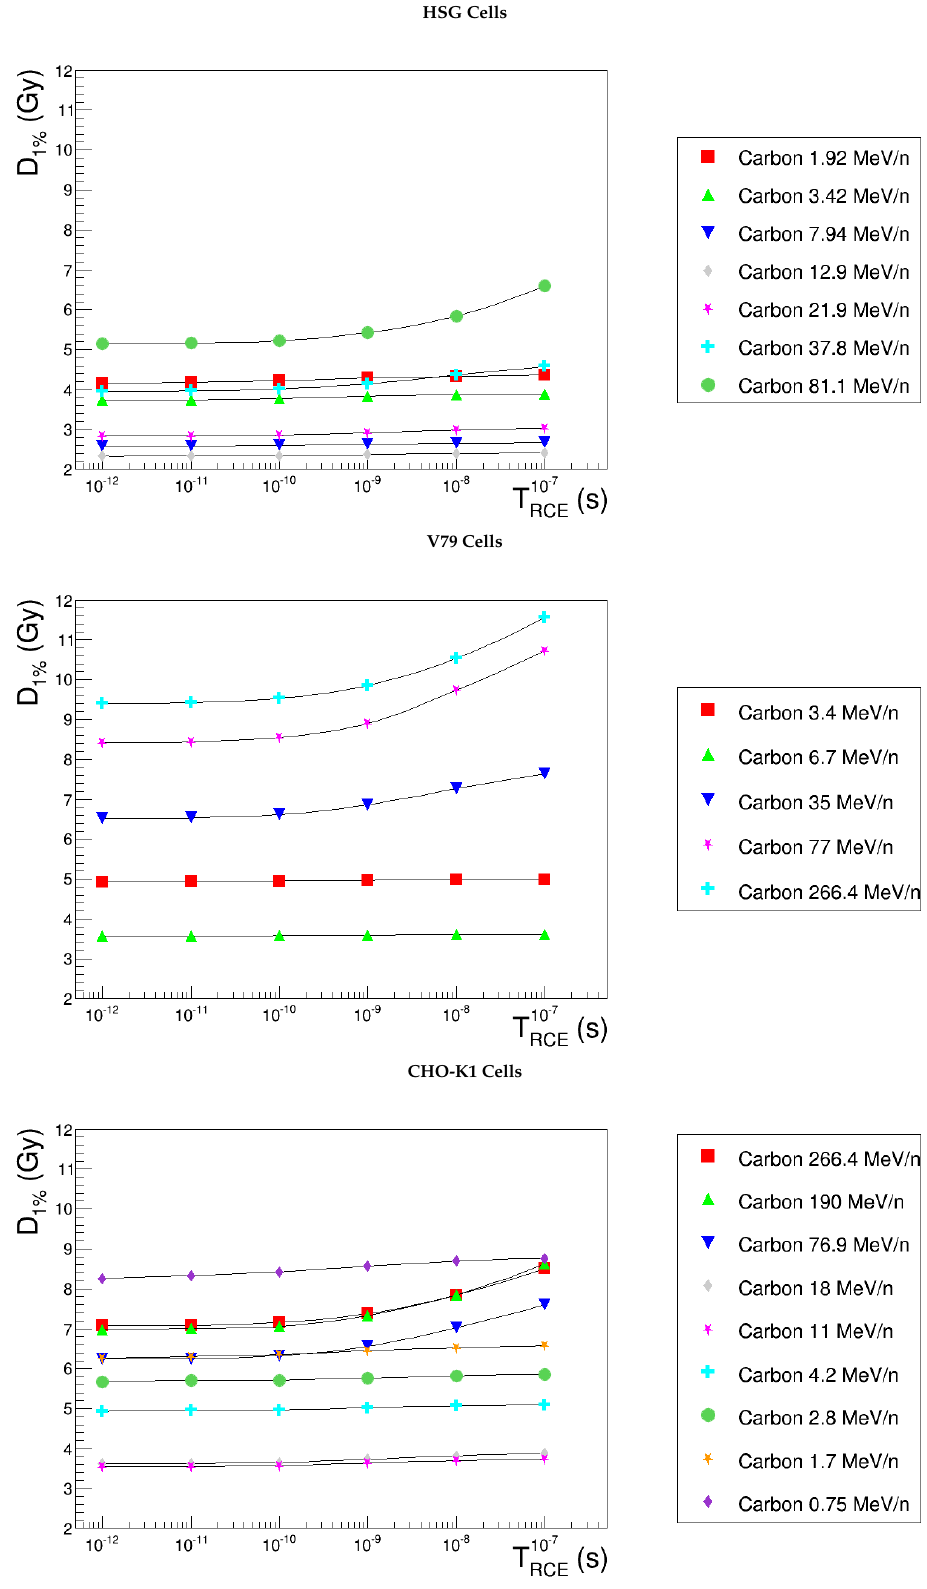
Figure 8. D 1% predicted by NanOx as a function of the time of OH radical diffusion, T RCE . The full symbols correspond to the LET values for which the estimates were performed, while the lines are drawn just to guide the eye and do not represent a